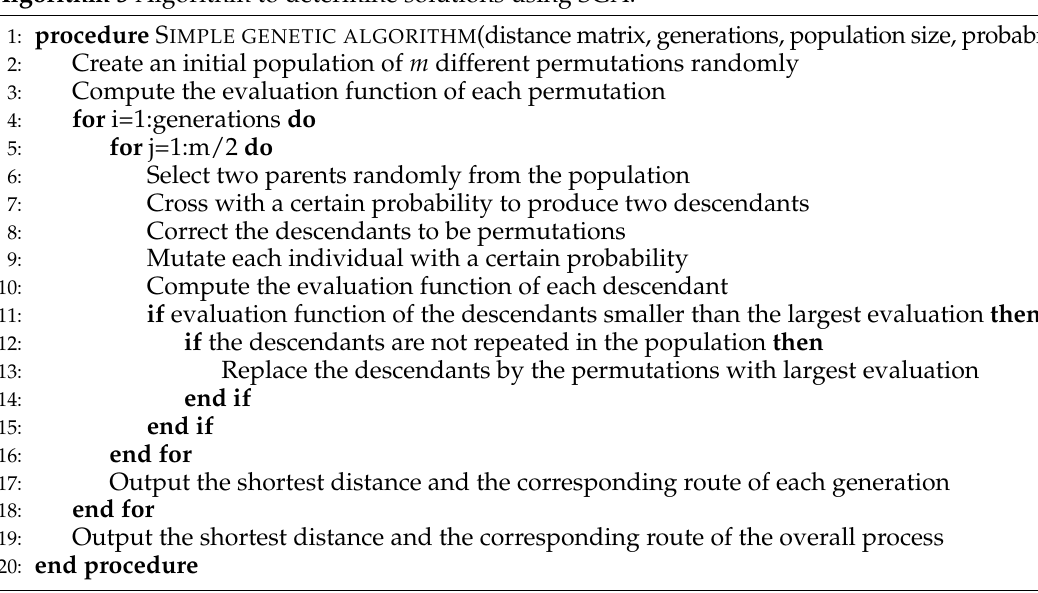
Algorithm 3 Algorithm to determine solutions using